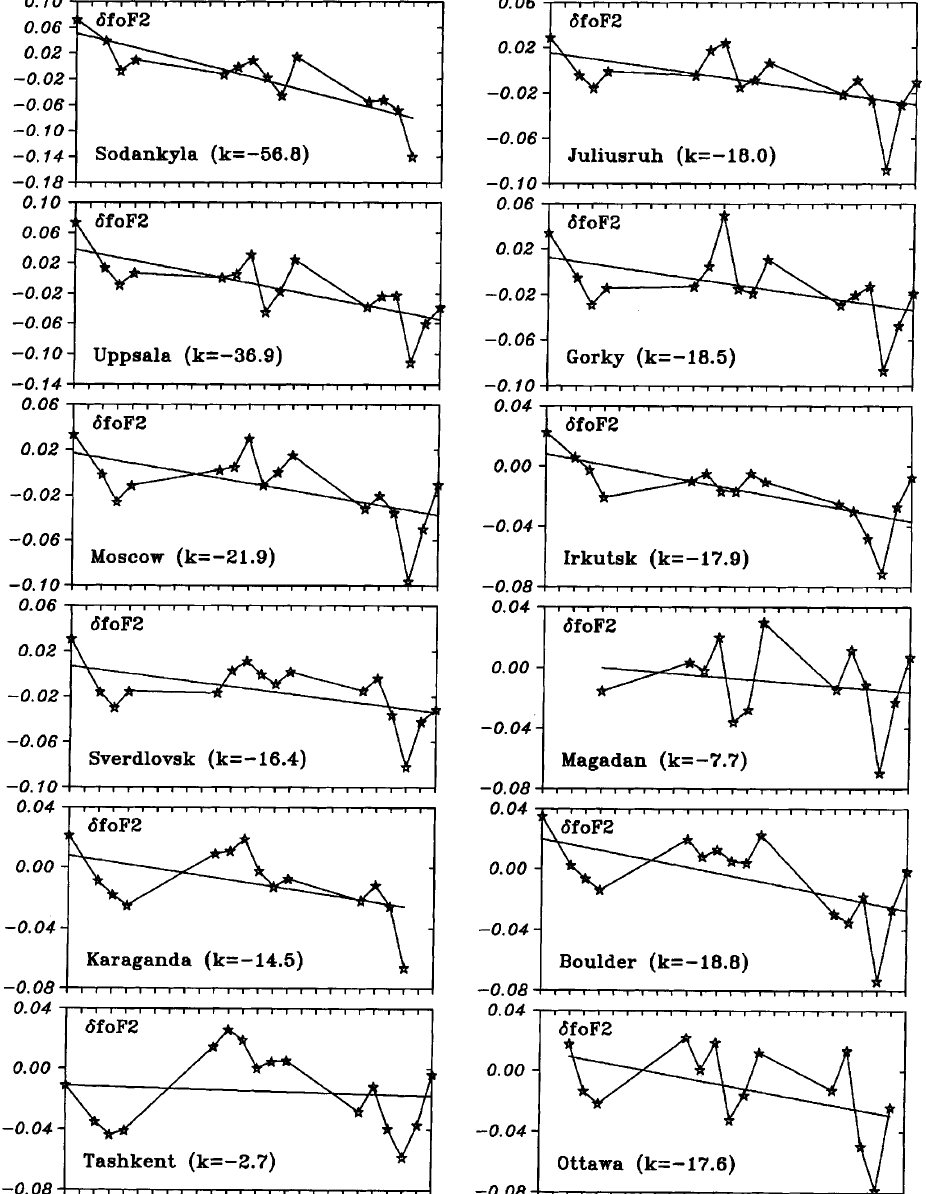
Fig. 1. The d fo F2 values versus a year for di(cid:128)erent latitudes ( left- hand panel ) and longitudes ( right- hand panel ) for April. The slope k of the regression line is shown in 10 ) 4